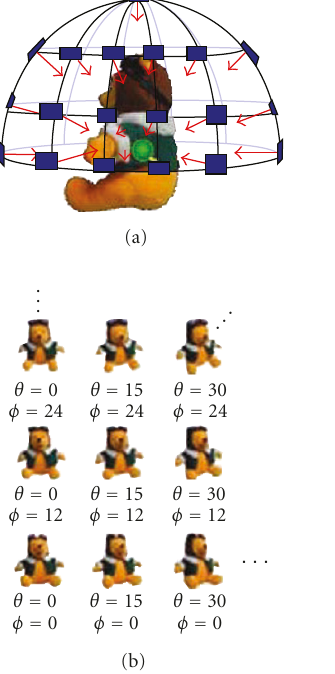
Figure 1: The image components of an object movie. The left shows the camera locations around Wienie Bear, and the right shows some captured images and their corresponding